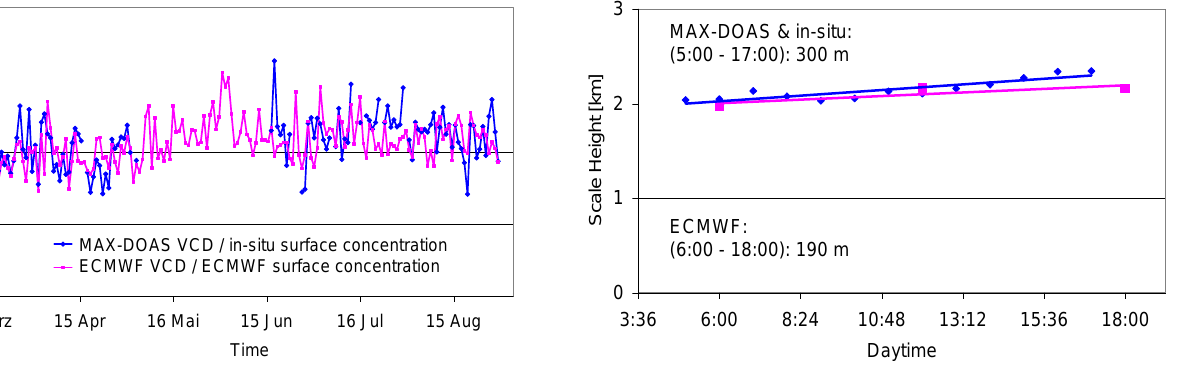
Fig. 19 Diurnal variation of hourly averaged scale heights derived from combined MAX- Fig. 19. Diurnal variation of hourly averaged scale heights derived DOAS (blue) and in-situ as well as ECMWF data (pink). Data are averaged between 5:00 and 17:00 for all days, for which MAX-DOAS data are available. from combined MAX-DOAS (blue) and in situ as well as ECMWF data (pink). Data are averaged between 05:00 and 17:00 for all days, for which MAX-DOAS data are available.